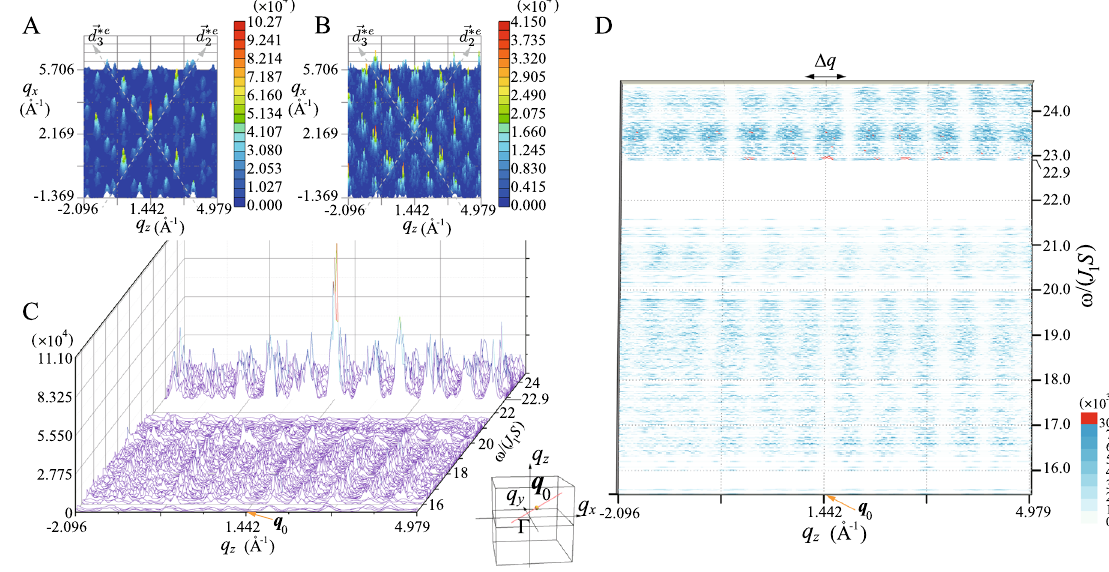
3.436 Å − 1 for ( A ) ω/( J 1 S ) = q 0 inside the cube with a side length of 2 line through